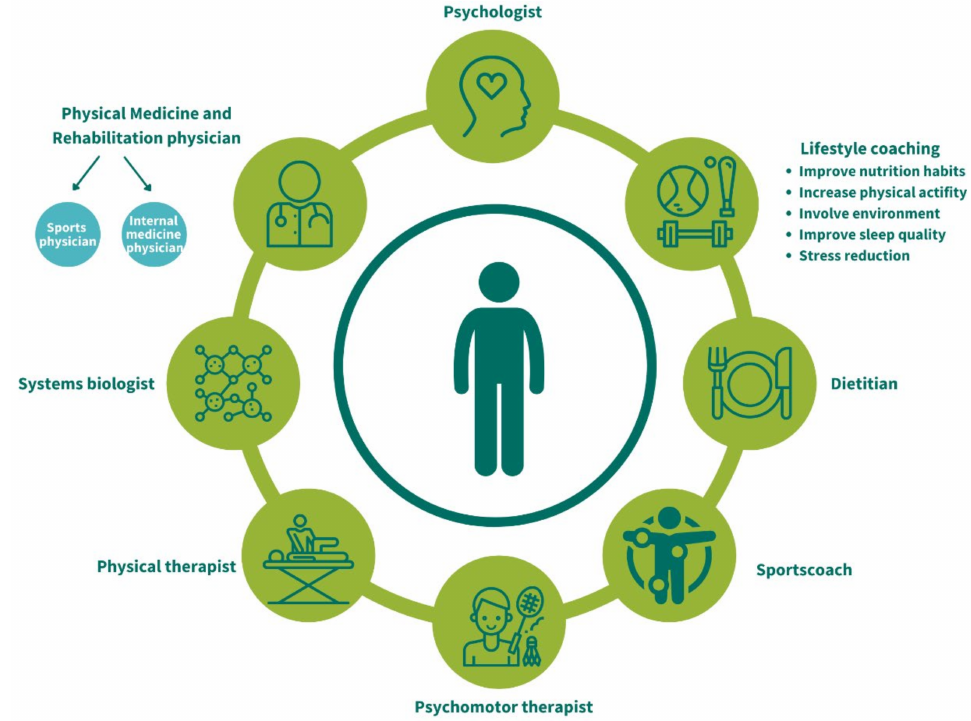
Figure 2. An overview of the healthcare professionals involved in the personalized integrative obesity-coaching program based on important factors from the system health